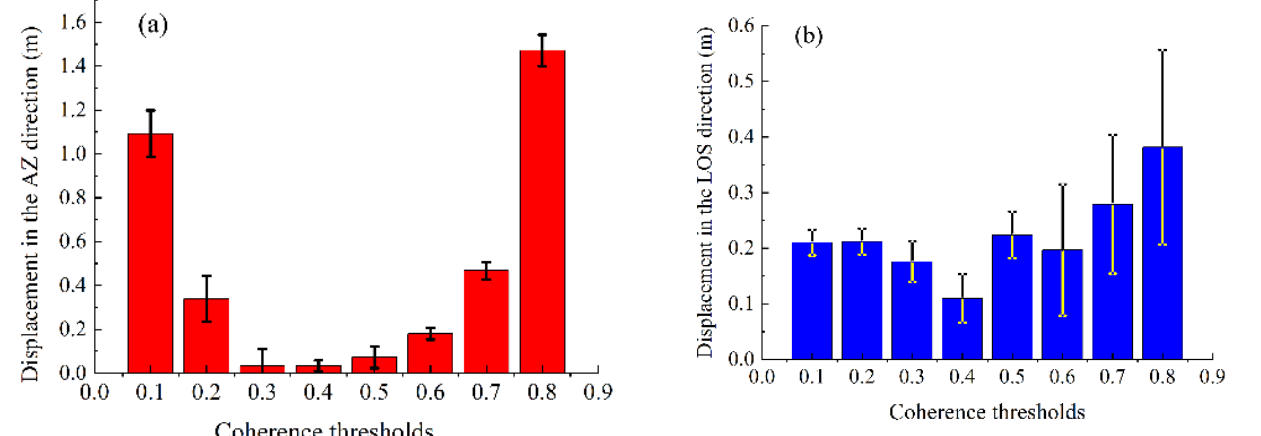
Figure 4. Displacement in the non-glacial area under different coherence thresholds. ( a ) Displacement in the azimuthal direction; ( b ) Displacement in the LOS direction.